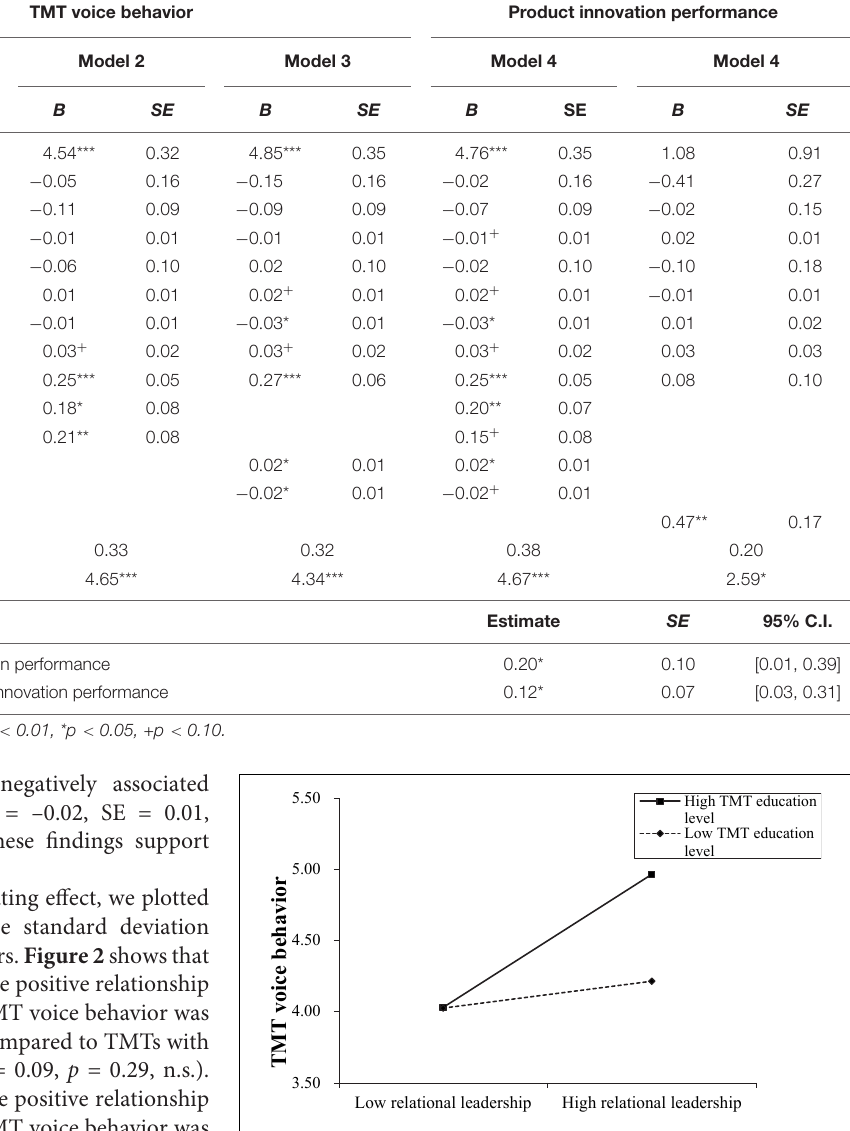
FIGURE 2 | The moderating role of TMT educational